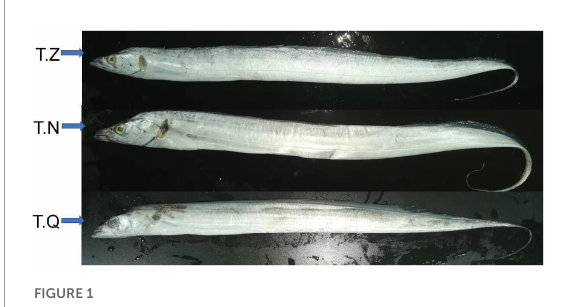
FIGURE1 External morphology of three origin